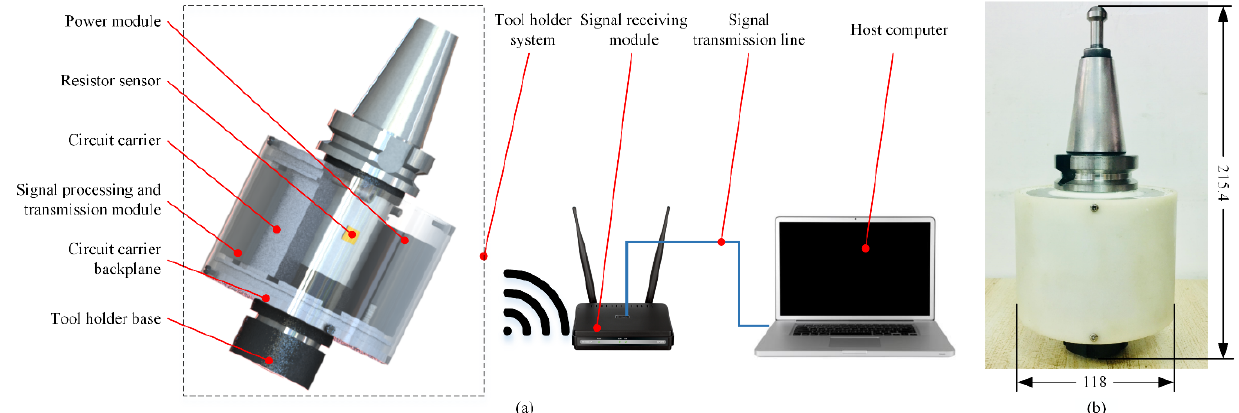
Figure 2. ( a ) composition of the cutting system; ( b ) cutting force on tool tip.